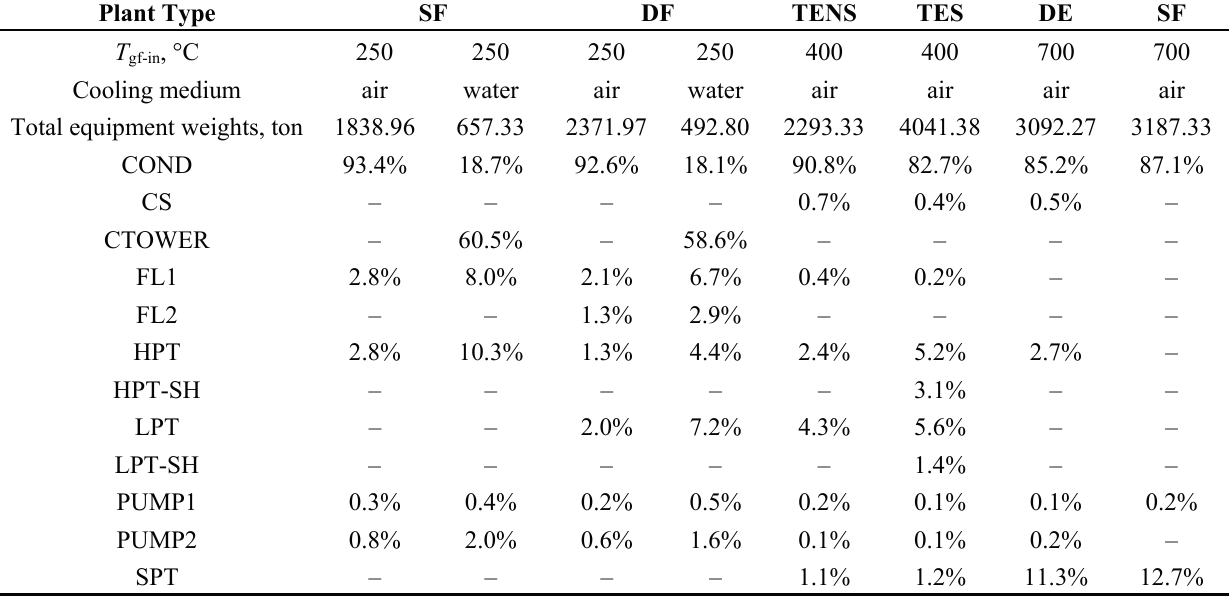
Table 6. Itemized equipment weights of selected power